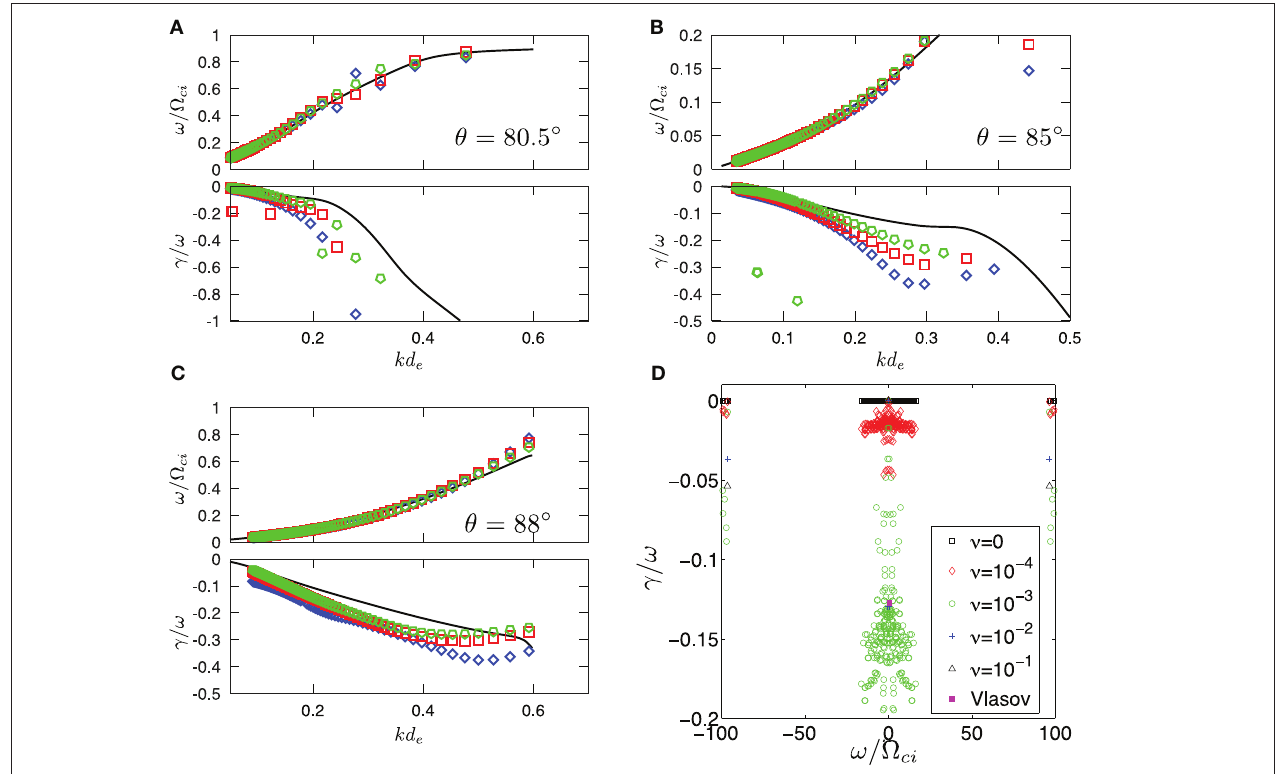
FIGURE 4 | Eigenvalues of the linearized algorithm for the angle of propagation θ square, and green pentagon symbols refers to N h values of the collisionality parameter ν